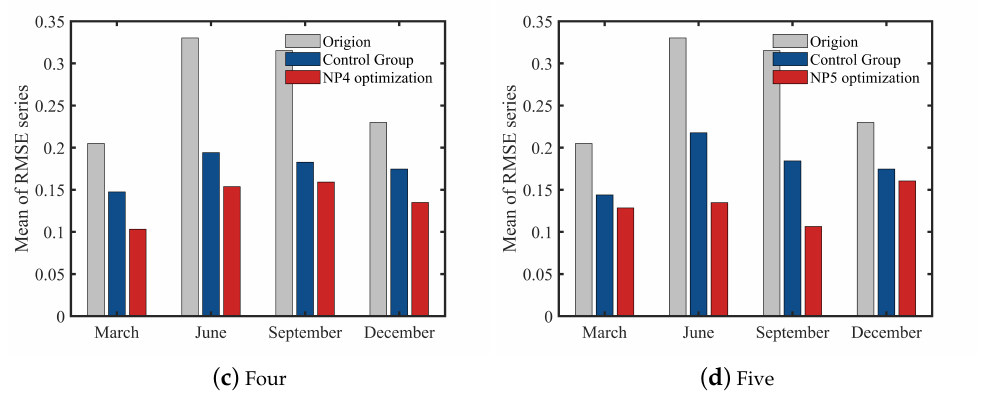
Figure 15. Average RMSE and its reduction rate of analysis in the control group and the experimental group of multi-platform